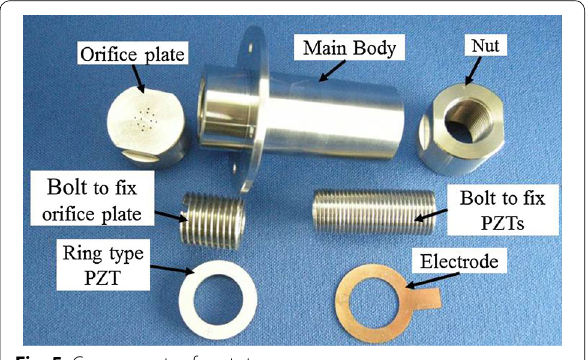
Fig. 5 Components of